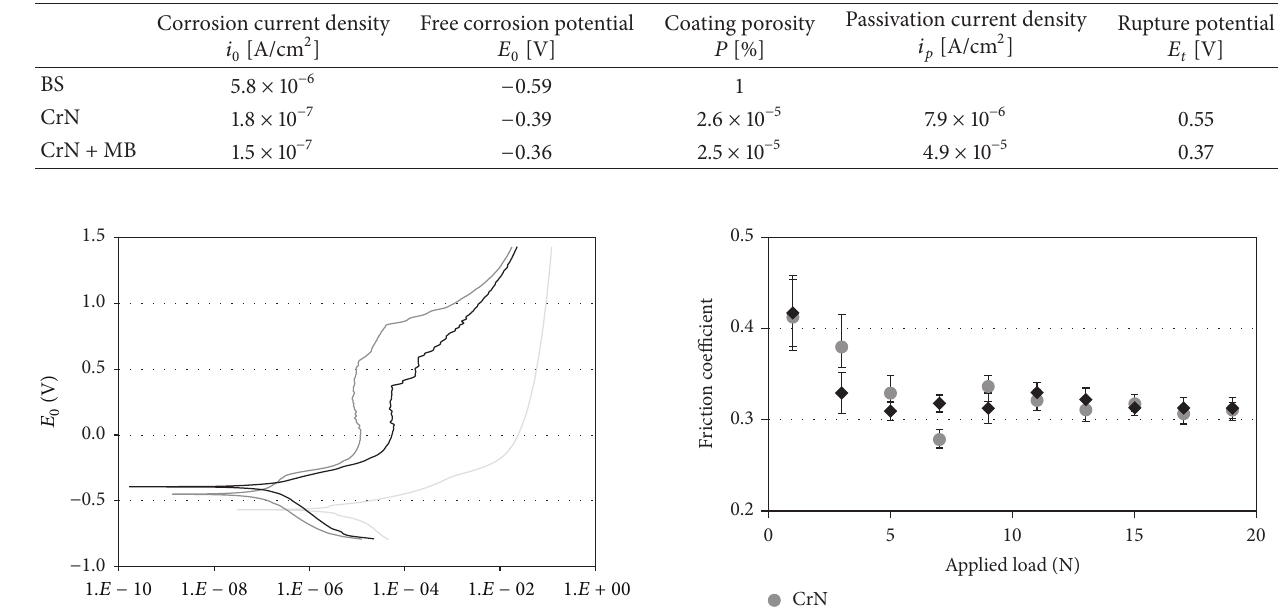
Table 3: Corrosion tests results.